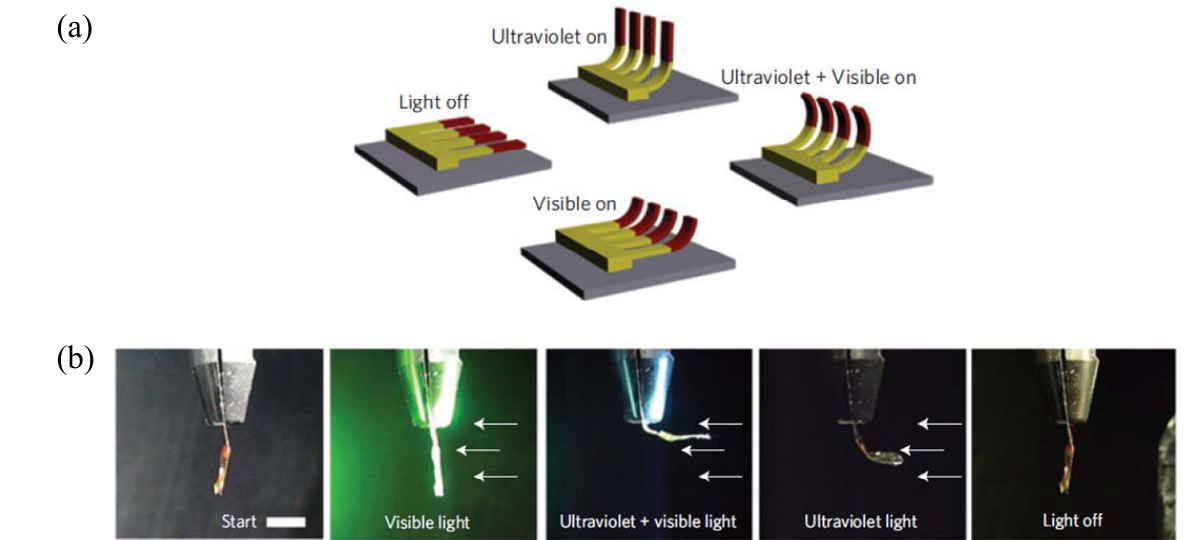
Figure 20. ( a ) Schematic representation of photo-driven artificial cilia by exposing to controlled wavelength of light. ( b ) Response of LCN actuator to two different wavelengths of light. Reprinted with permission from Macmillan Publishers Ltd. [Nature Materials], copyright (2009)